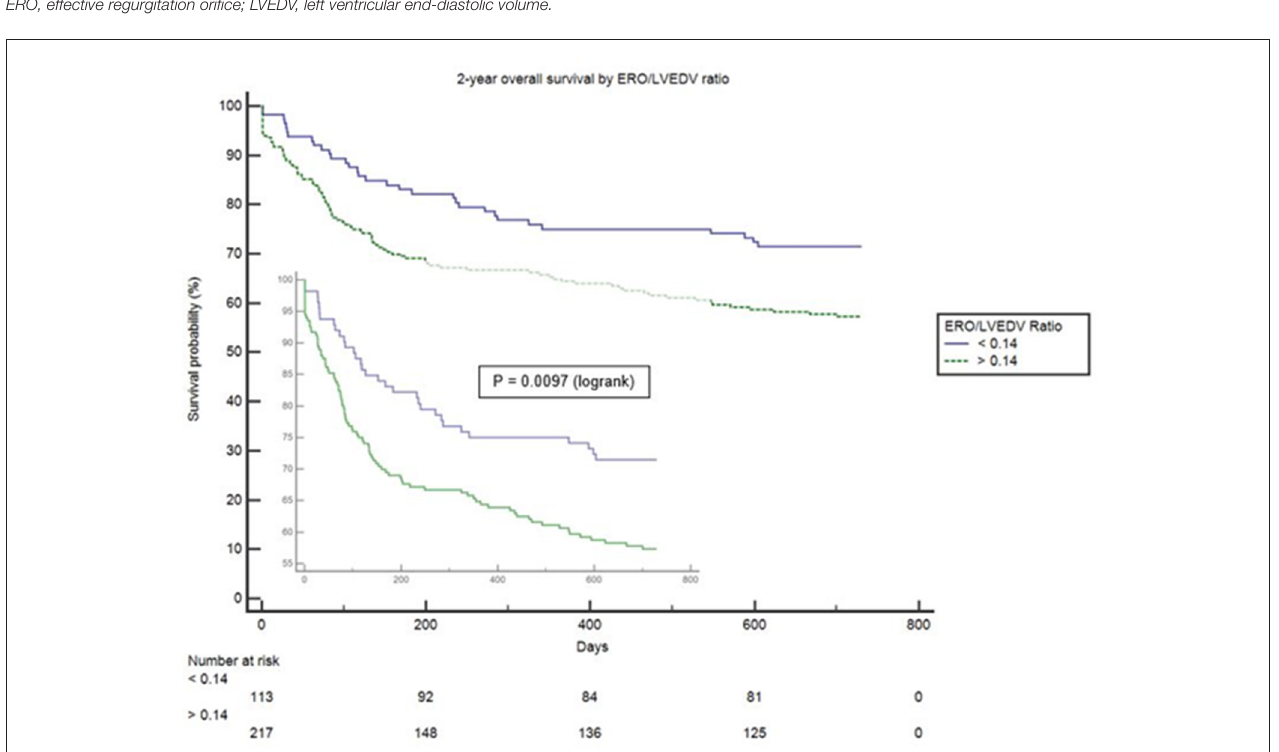
FIGURE 4 | Unadjusted survival curve of 2-year all-cause mortality comparing proportionate and disproportionate MR, defined by an ERO/LVEDV ratio.